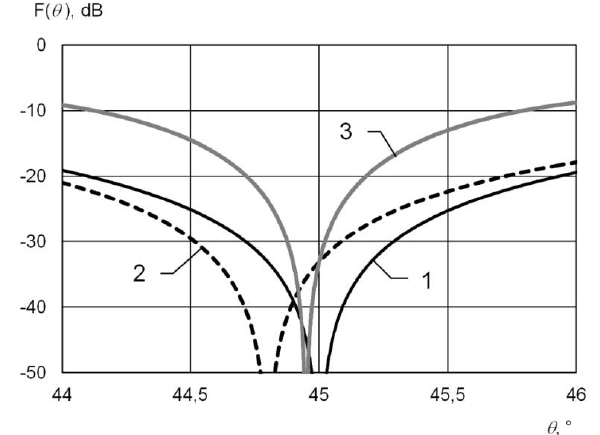
Fig. 3. Difference radiation patterns of PAA with beam deflection by 45°.